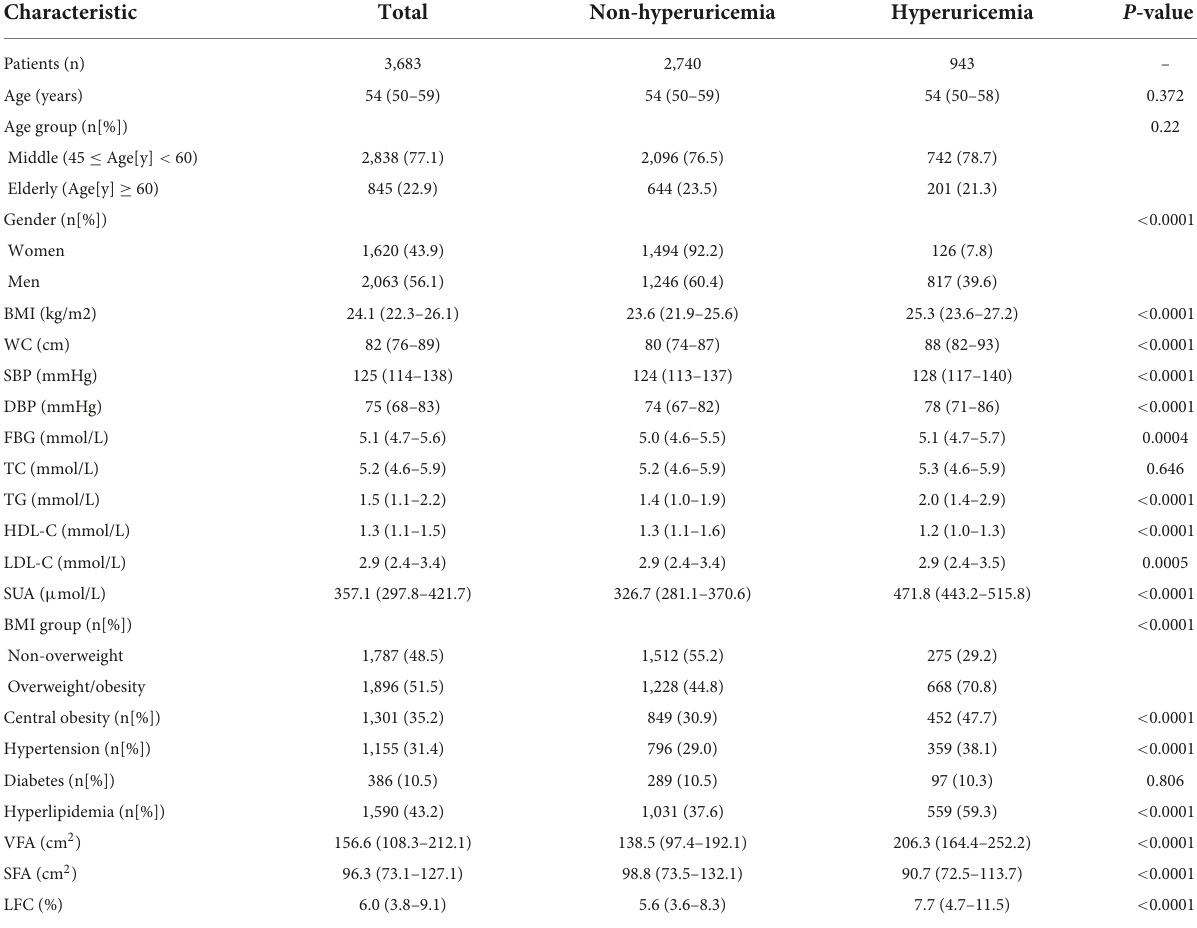
TABLE 1 Characteristics of the participants according to serum uric acid status ( N =